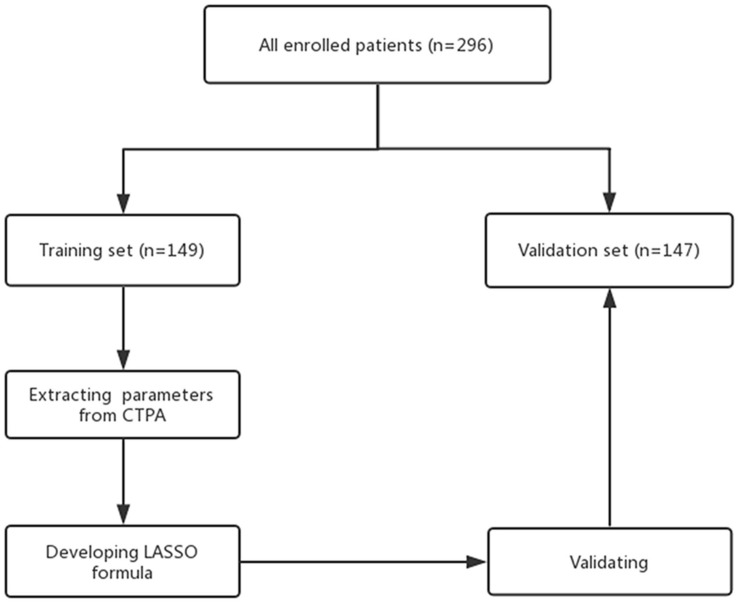
Flow chart of the validation process.